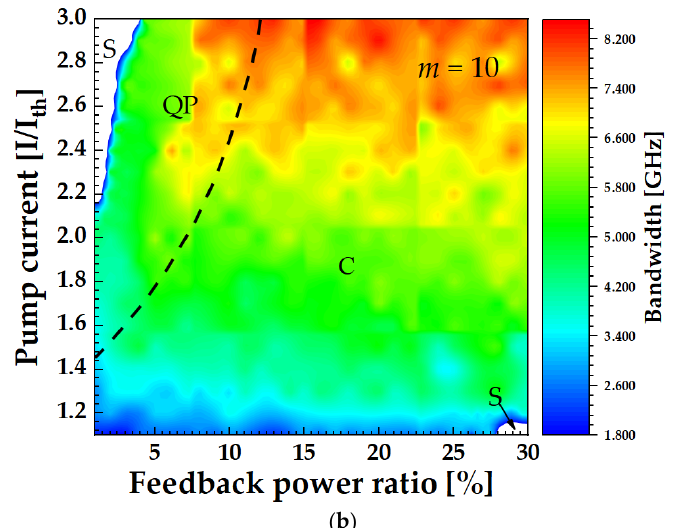
Figure 13. Bandwidth vs. feedback power ratio and pump current, with τ f = 2.4 ns. ( a ) m = 5, ( b ) m = 10.